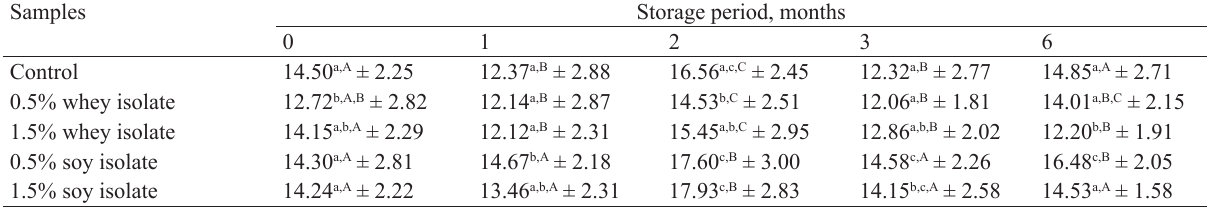
Table 5 a * values of sausages with protein isolates during storage (average ± SD) Samples